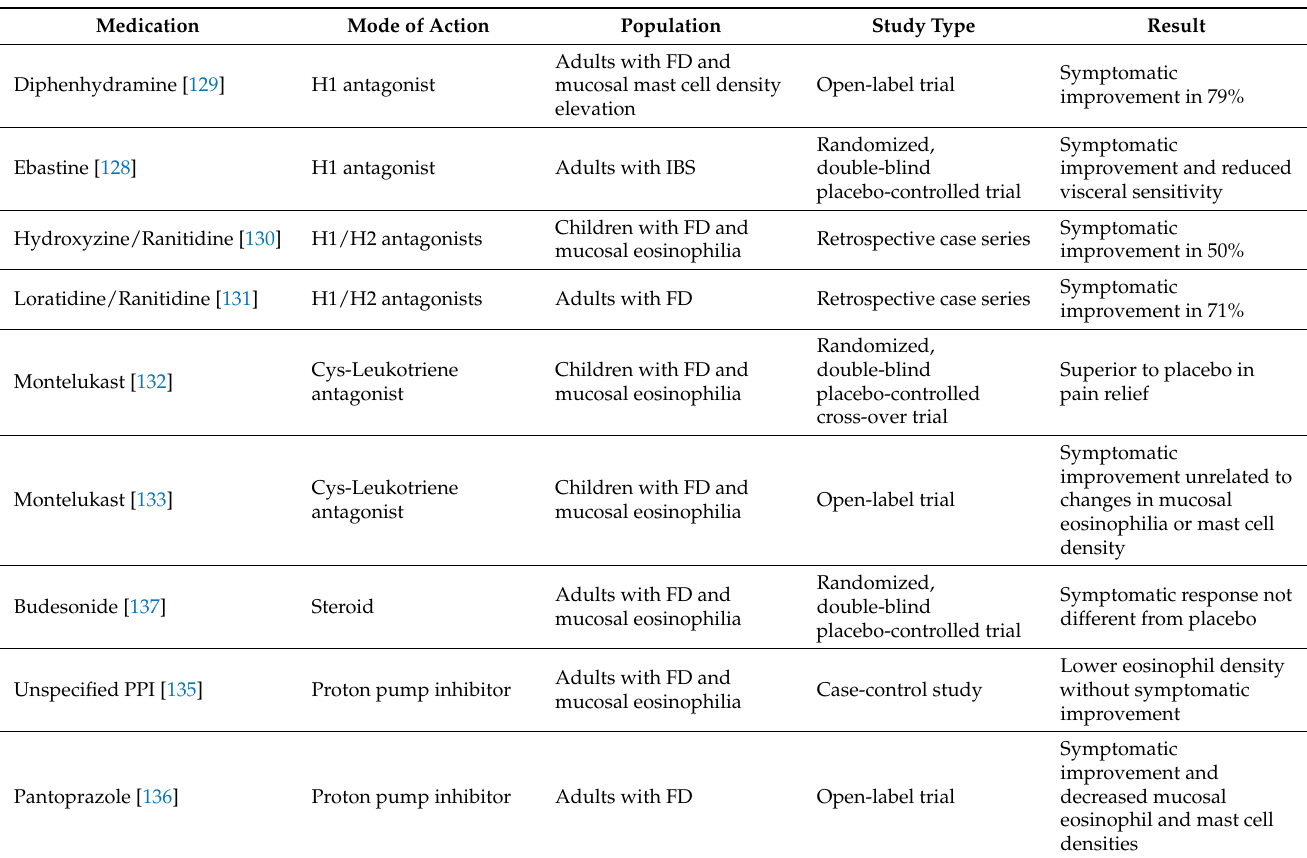
eosinophilia, treatment with pantoprazole was associated with improved symptoms and reduced mucosal eosinophil density [136]. Table 1. Trials in functional abdominal pain disorder patients utilizing medications with reported benefits in allergic